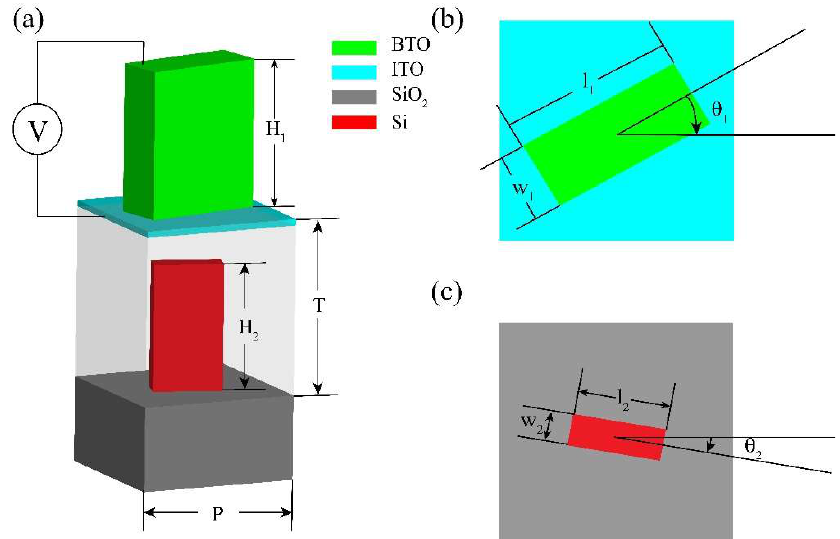
Figure 2. (a) Diagrams of the unit cell, the upper layer is BTO nanofin and the bottom layer is Si nanofin. (b, c) represent the schematic diagrams of the upper layer and lower layer rotation angles. The parameters of BTO nanofin and Si nanofin are l 1 , w 1 , H 1 and l 2 , w 2 , H 2 , respectively. θ 1 and θ 2 are rotation angles of BTO nanofin and Si nanofin. P is the period of the unit cell. T is the distance between the two layers.